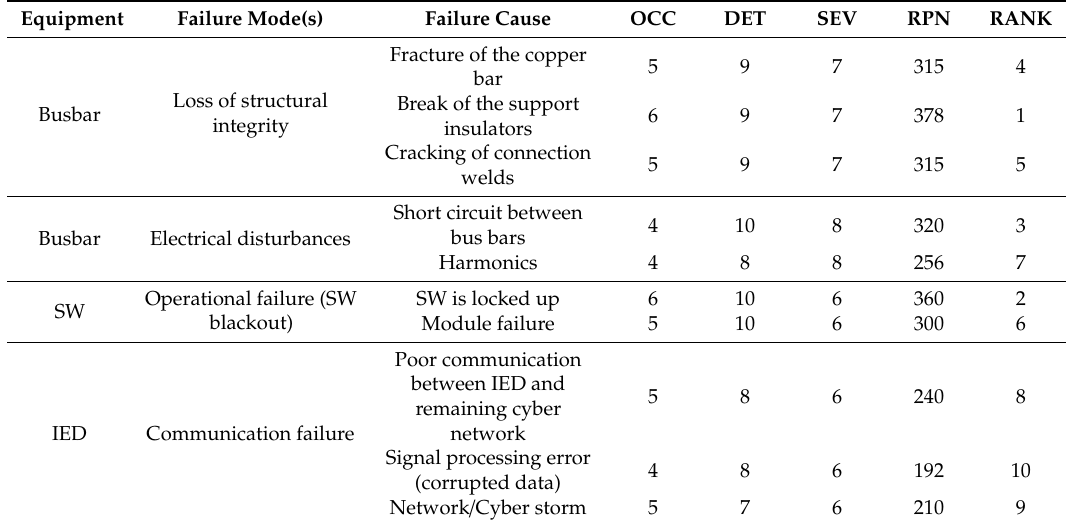
Table 11. Selected failure modes for analysis and